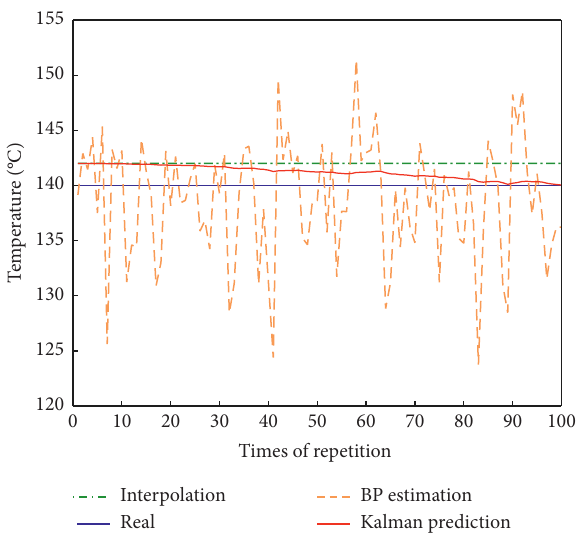
Figure 10: Performance comparison with 100 times of